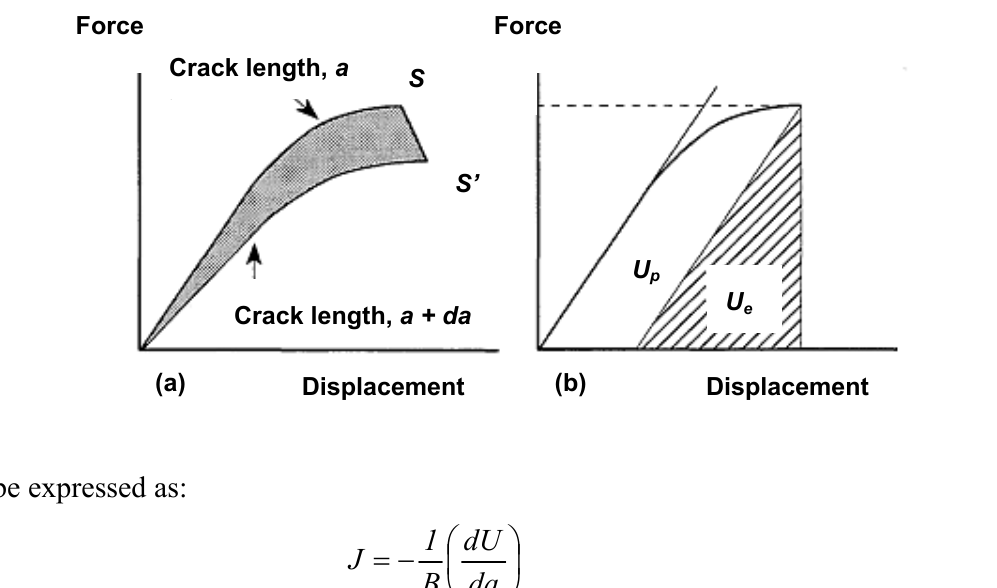
Figure 8. Elastic-plastic behaviour. ( a) Decrease of the potential energy due to crack growth; (b) Separation of the elastic and plastic